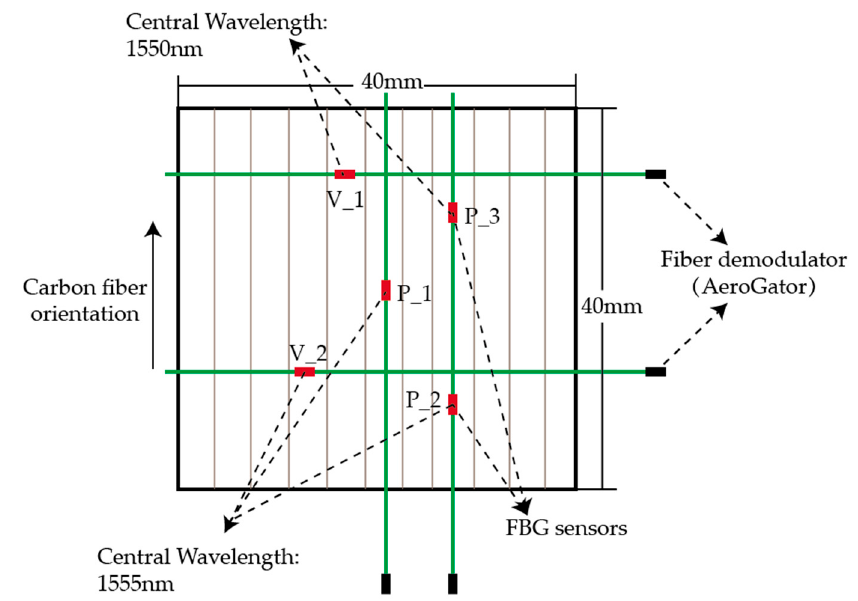
Figure 7. Layout of the FBG sensor in two